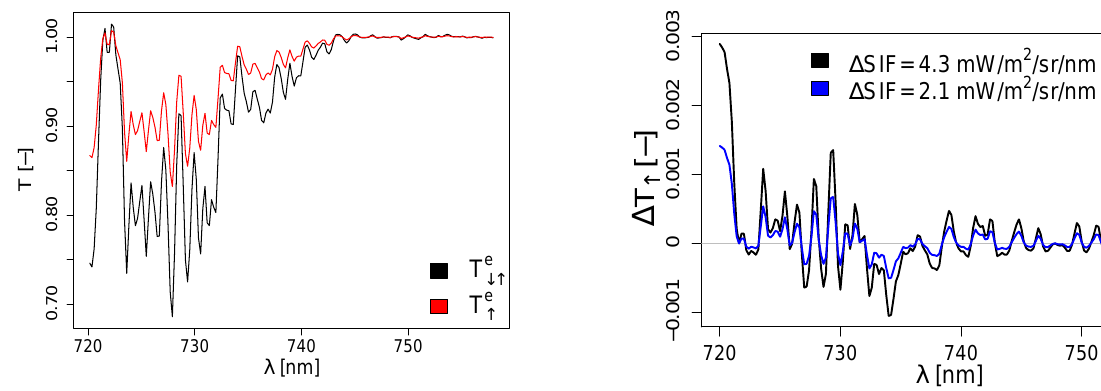
Figure 4. Changes in the estimated effective ground to sensor trans- mittance ( T e ↑ ) for a medium (2 . 1mWm − 2 sr − 1 nm − 1 , blue) and a large (4 . 3mWm − 2 sr − 1 nm − 1 , black) SIF emission difference. Simulated TOA radiances (described in Sect. 4) without instrumen- tal noise have been used for the calculation of T e ↑ in the 720–758nm fitting